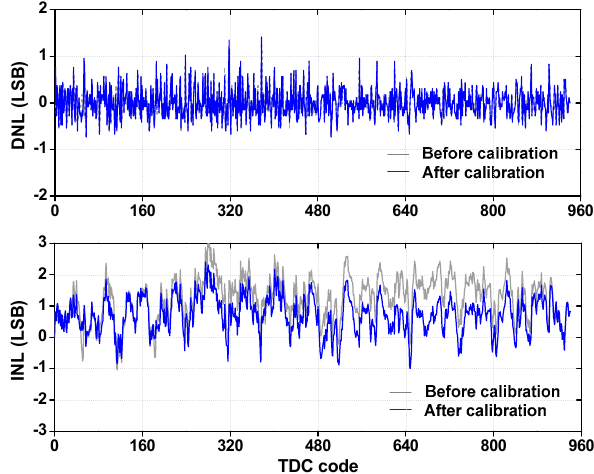
Figure 17. Measured differential nonlinearity (DNL) and integral nonlinearity (INL) of the TDC.